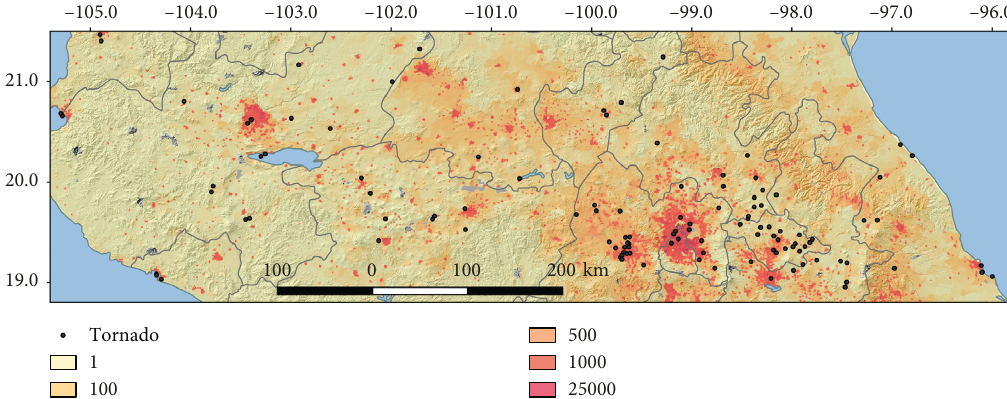
Figure 5: Population density (inhabitants per km 2 ) [39] and position of documented